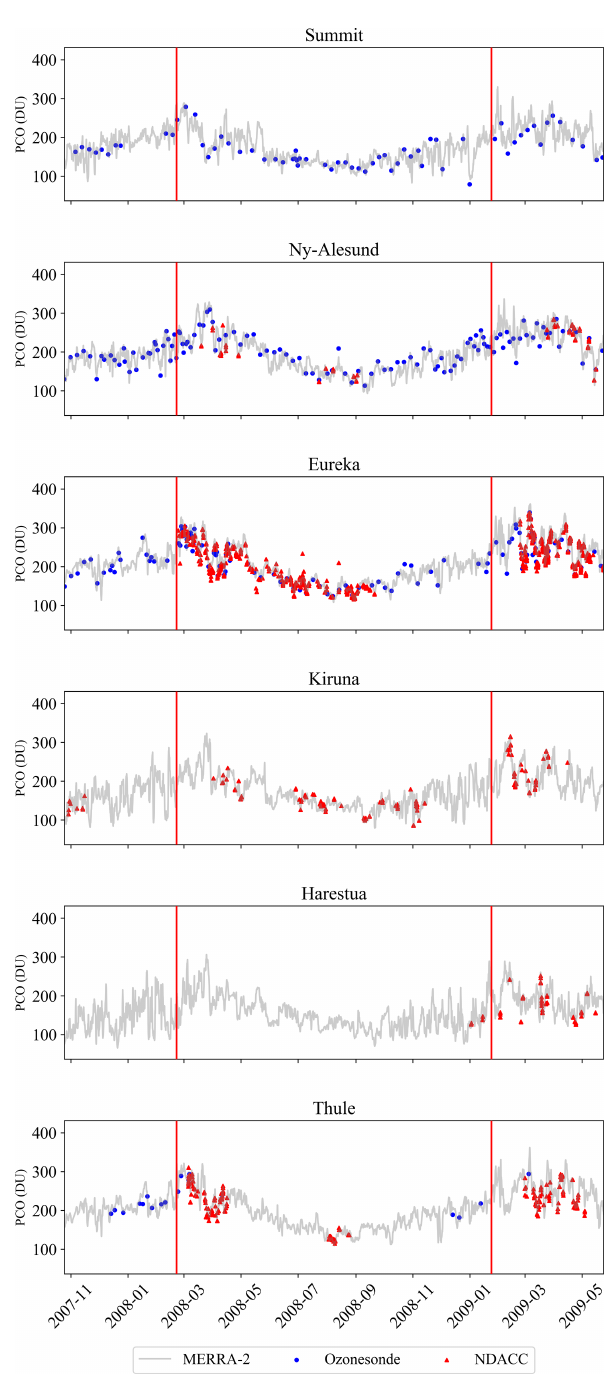
Figure 2. Time series of 3-hourly partial column ozone (PCO) of ground to 20km derived from MERRA-2, solar FTIR, and ozonesondes at the study sites from winter 2007 to spring 2009. MERRA-2 is shown by the gray line. NDACC FTIR data and ozonesondes are shown by red triangles and blue circles, respec- tively. The vertical red lines highlight the dates of the 2008 and 2009